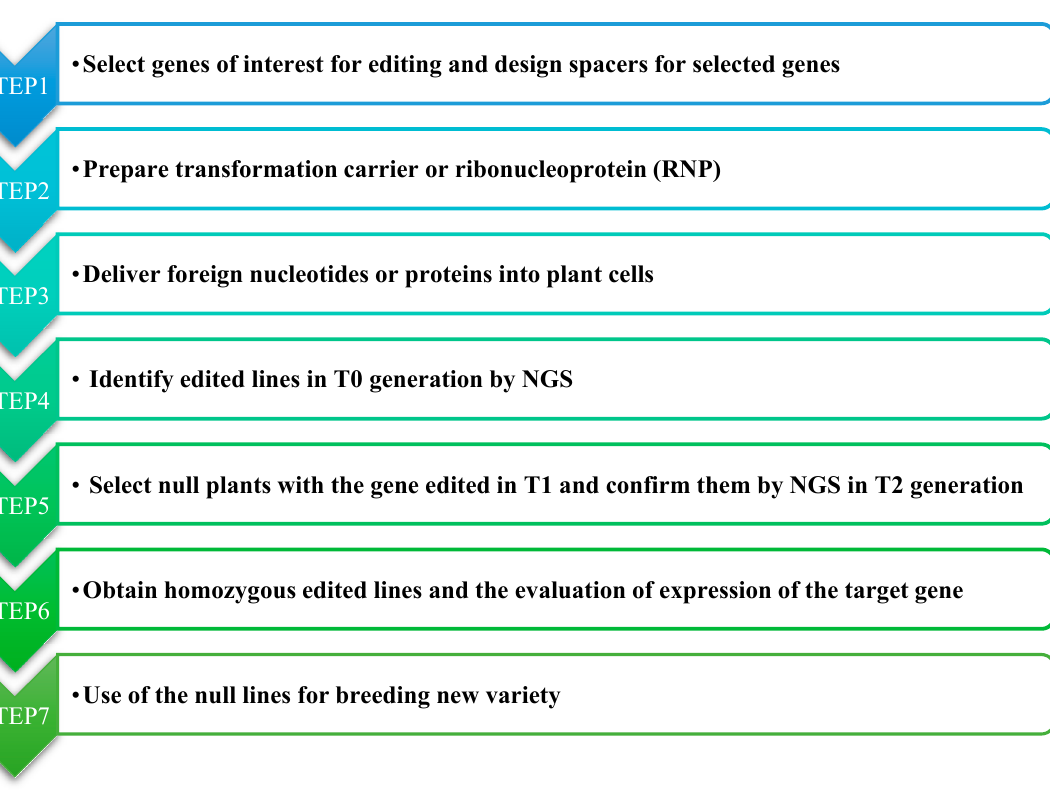
Figure 1. The workflow of CRISPR/Cas9-based gene editing in plants.